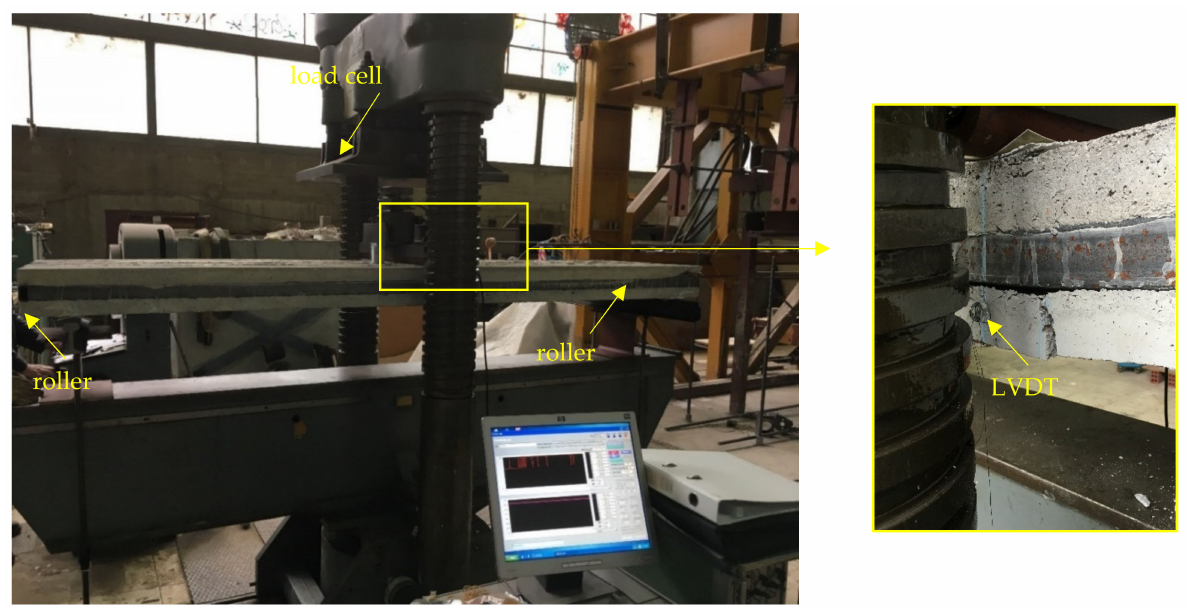
Figure 3. Experimental setup of the three-point bending test on PCSP-1